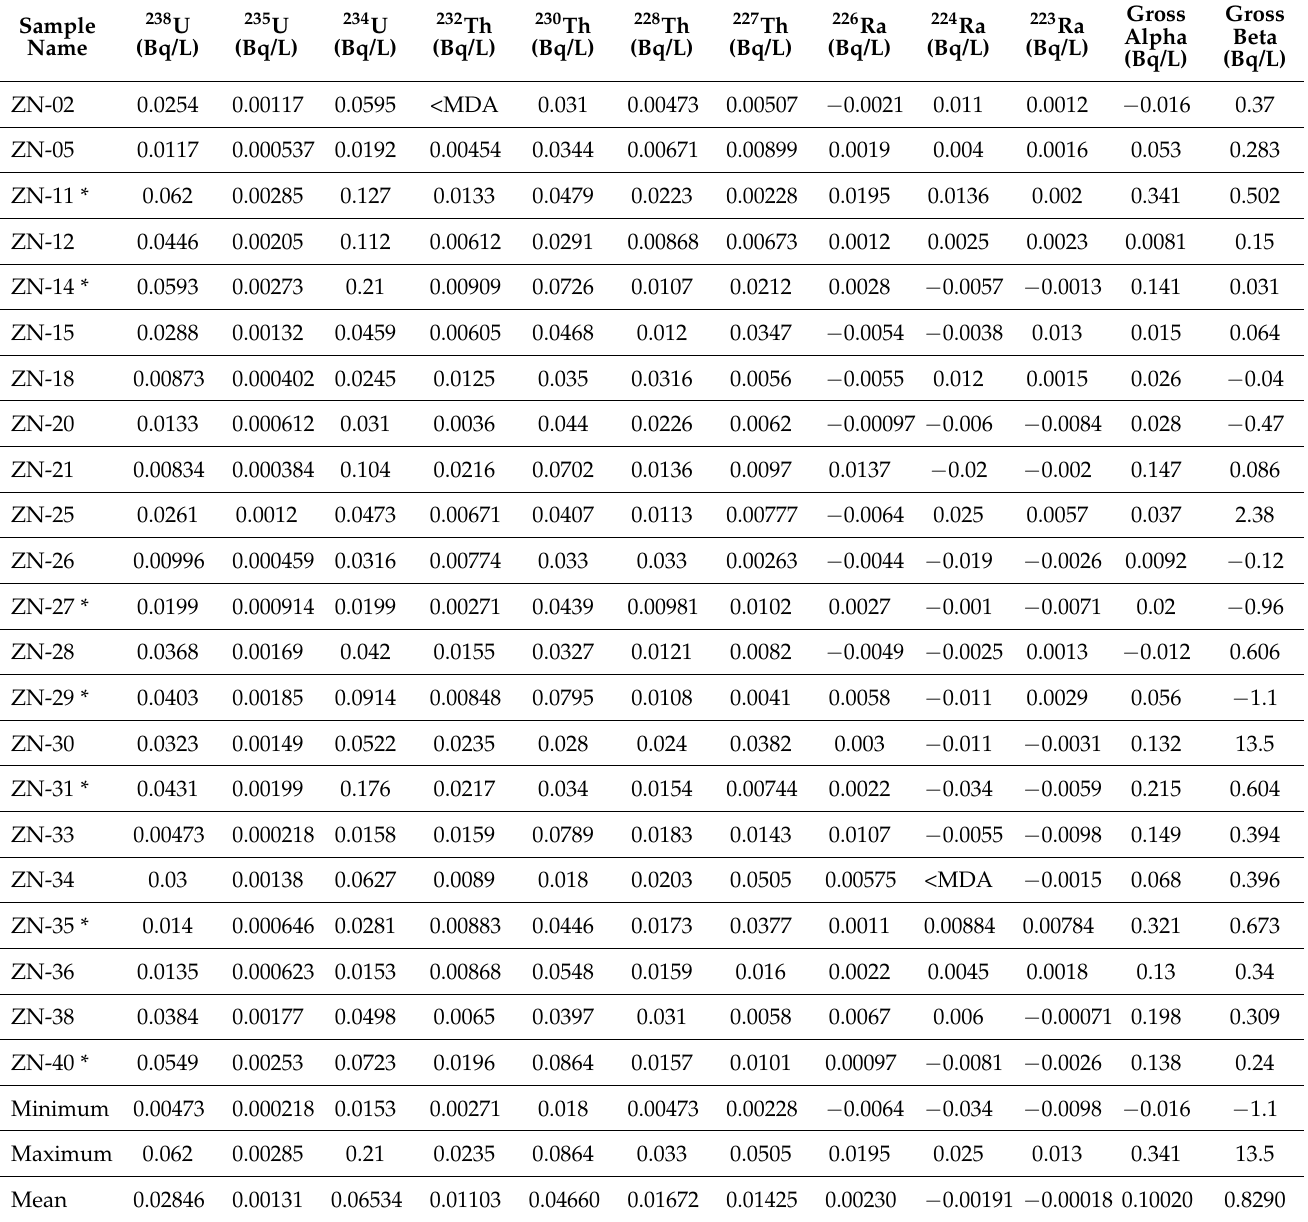
Table 1. Alpha spectrometry-based activity concentrations of major radionuclides in drinking water from the West Rand and the associated recommended